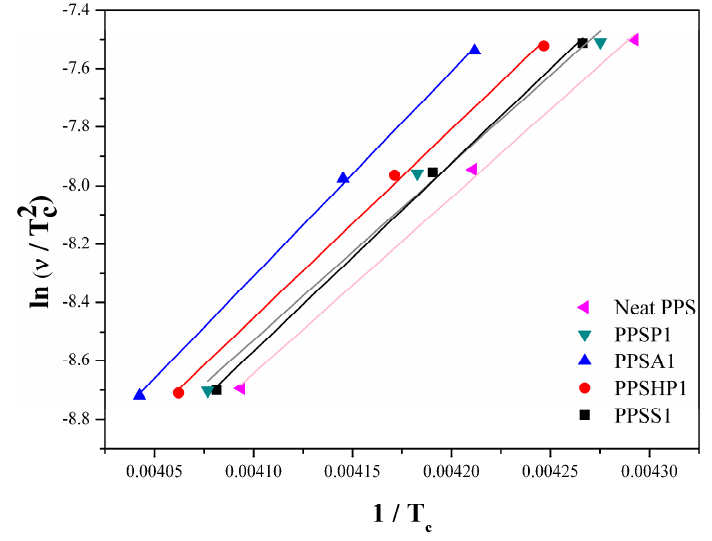
Figure 12. Kissinger plots of ln ((cid:1874)/(cid:1846) (cid:3030)(cid:2870) ) versus 1/(cid:1846) (cid:3030) of the PPS/MWCNTs composites. Table 4. The activation energy of non-isothermal crystallization of the PPS/MWCNTs composites. Sample